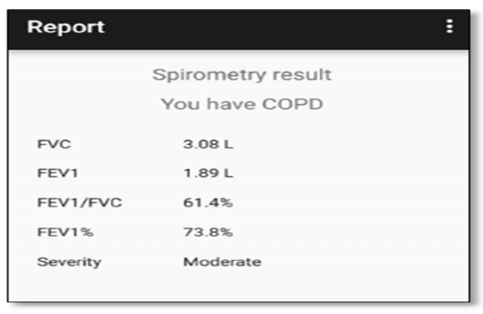
Figure 6. Report Activity Display.